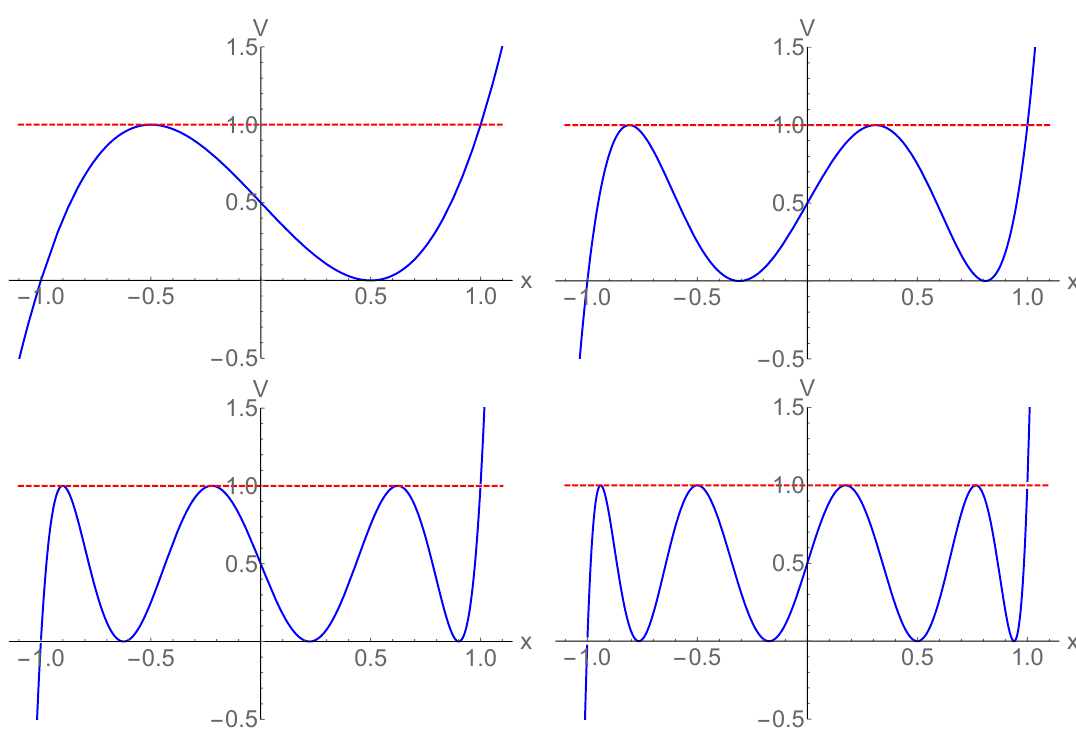
Figure 2 . The Chebyshev potentials V ( x ) = T 2 ( x ) in (3.1), for m = 3 = 2 ; 5 = 2 ; 7 = 2 ; 9 = 2. (The m case m = 1 = 2 corresponds to the soluble linear potential.) Note that all maxima are at energy u = 1, and all minima are at energy u = 0. This class generalizes the cubic oscillator well potential V ( x ) = T 2 ( x 3 = 2